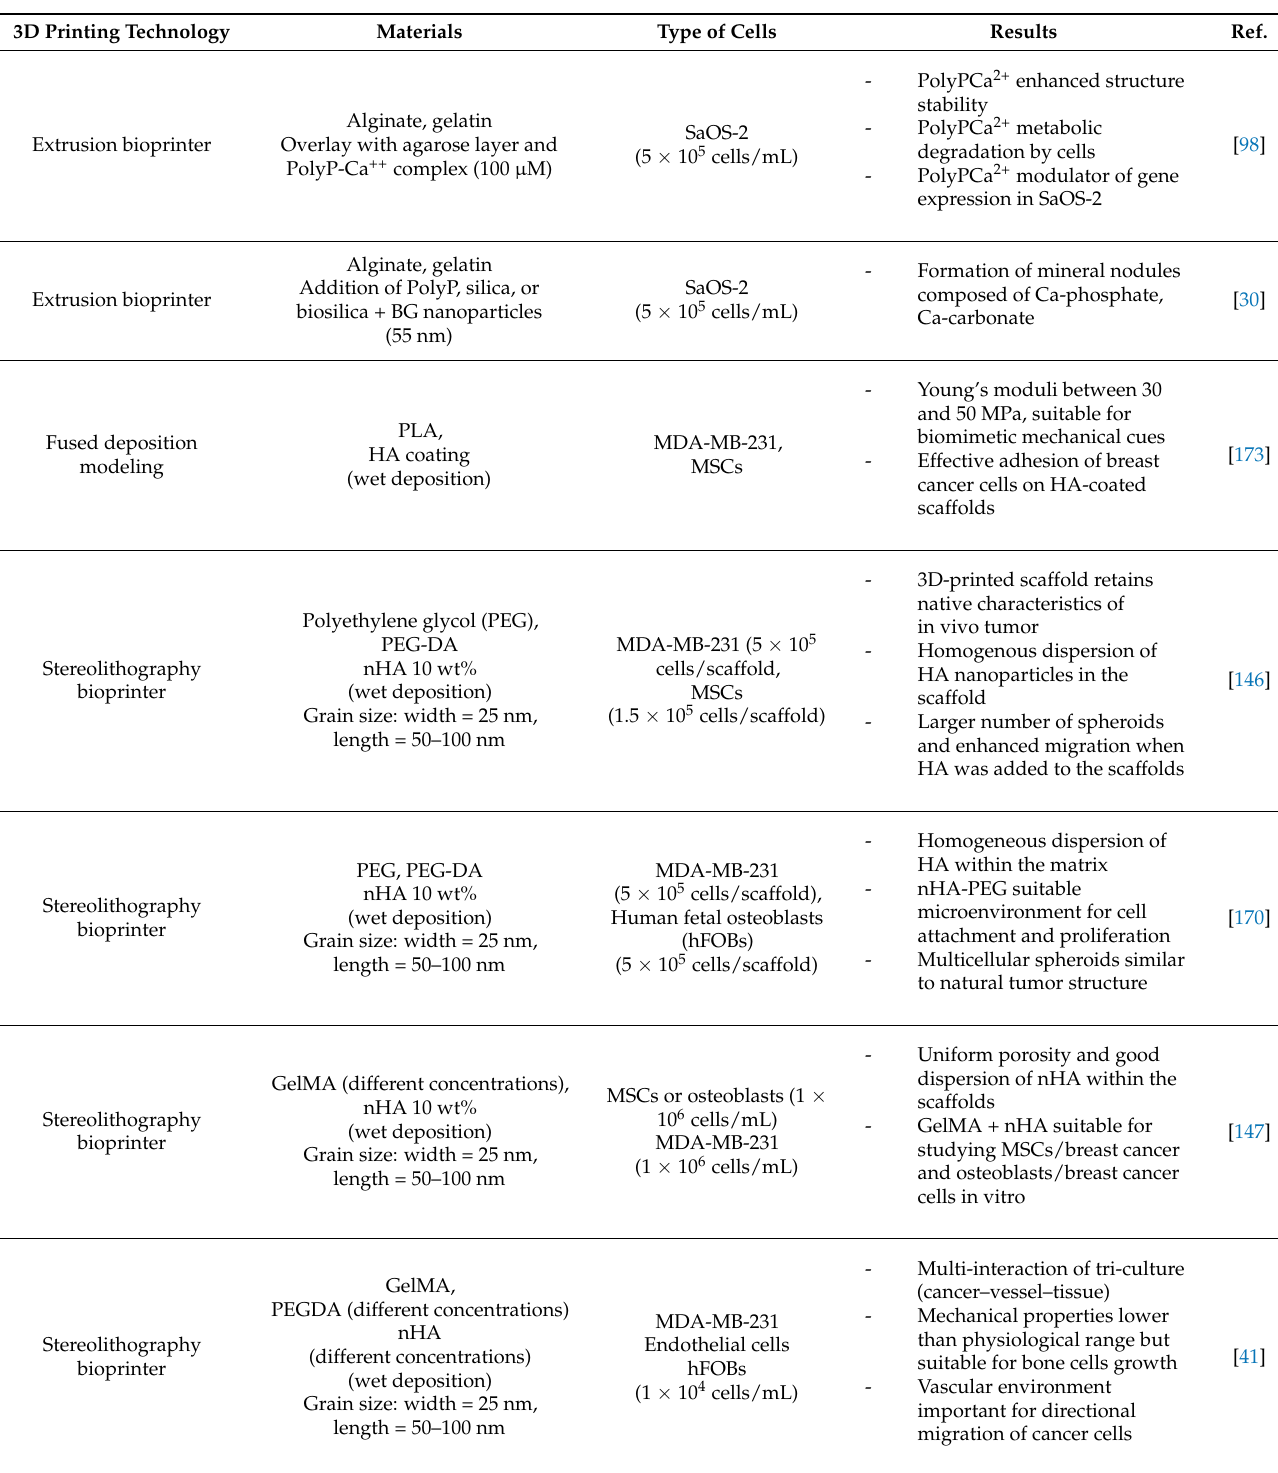
Table 1. Summary of reports on 3D bone bioprinting for the development of 3D bone tumor in vitro